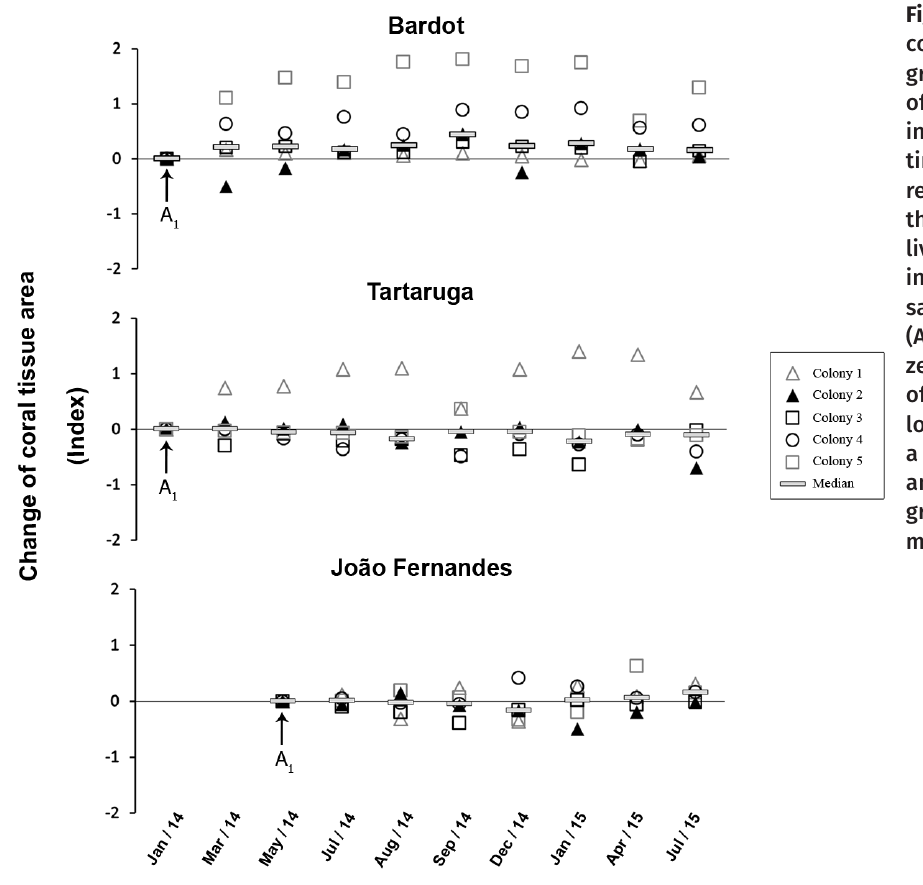
Figure 5. Index of live coral tissue area. The graph shows the indices of repeated samples of individual corals over time on three sampled reefs. The index considers the variation of the live coral tissue area in relation to the first sampling of each colony (A ). Values higher than 1 zero indicate a retraction of the turf, while values lower than zero indicate a loss of the coral area and turf overgrowth. The grey bar represents the